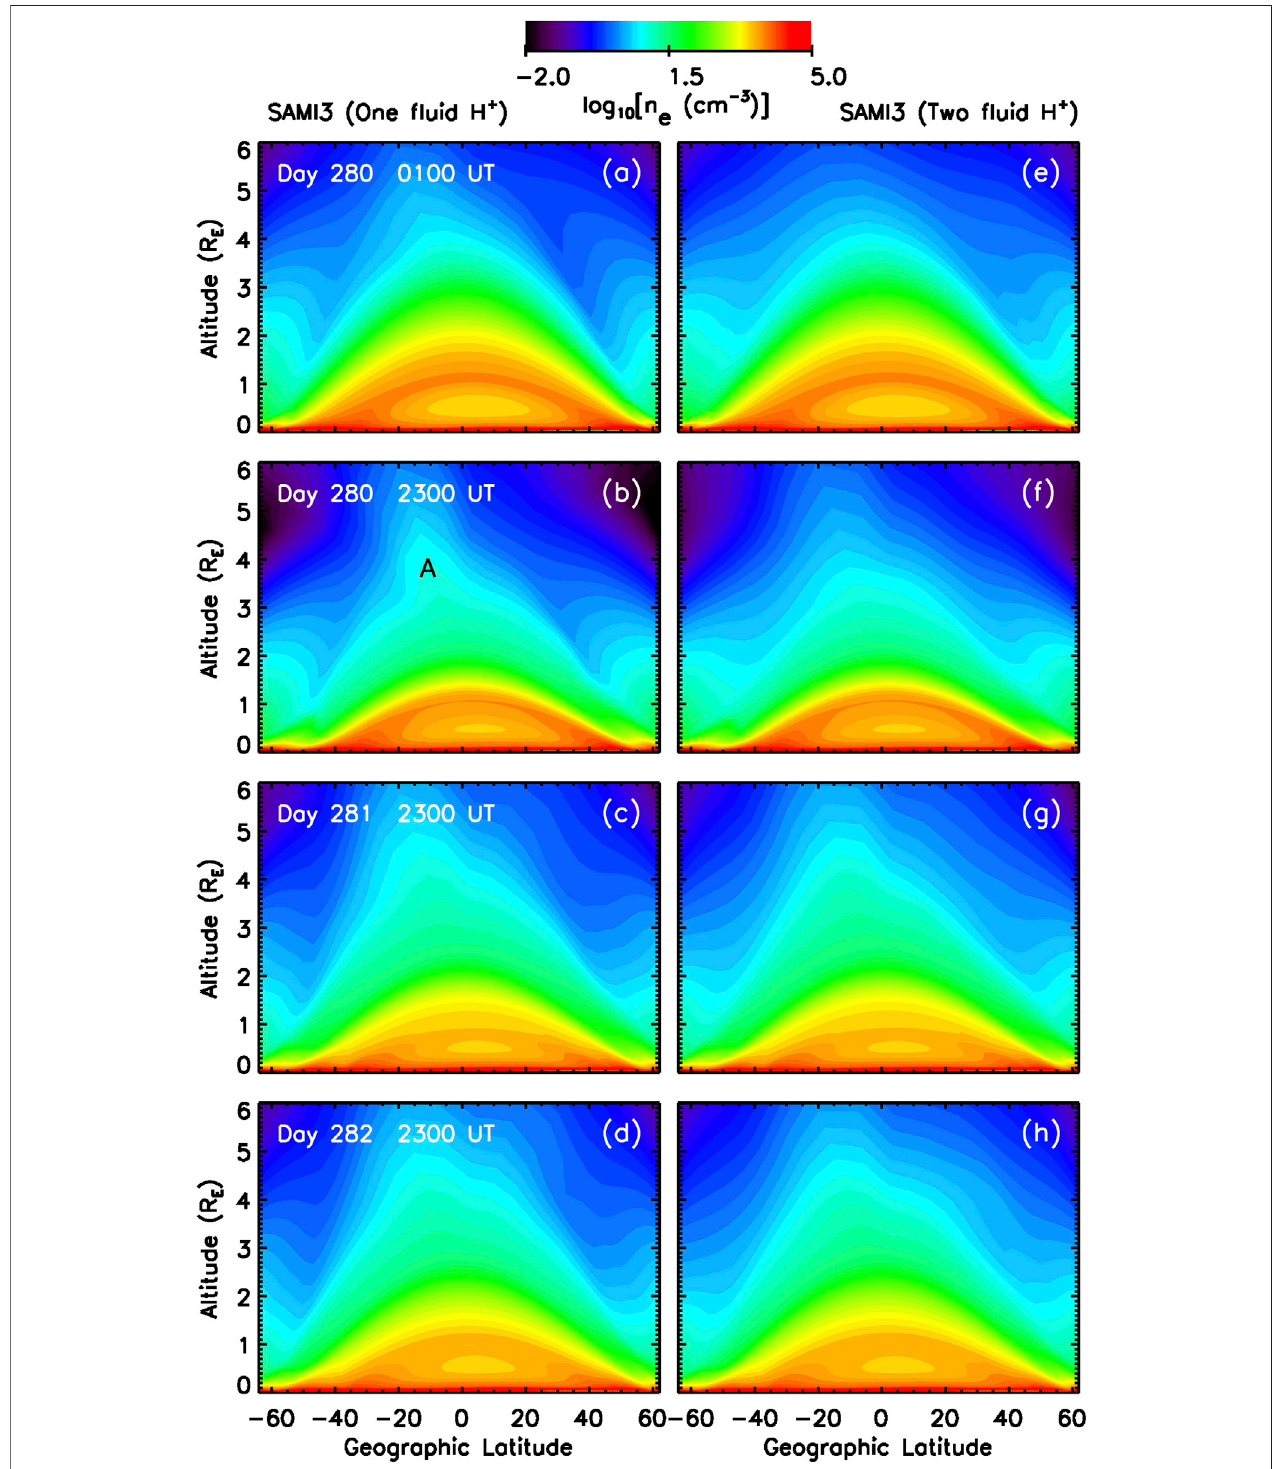
FIGURE 2 | Color contours of the log of the electron density are shown at times (A,E) 0100 UT Day 280 (before the storm), (B,F) 2300 UT Day 280 (during the storm), (C,G) 2300 UT Day 281 and (D,H) 2300 UT Day 282. Plots (A – D) are from SAMI3; plots (E – H) are from two-stream SAMI3. The density peak ( ‘ A ’ ) in panel (B) is caused by colliding H + streams from the two hemispheres. While a weaker version of feature A seems to be present in the two-stream SAMI3 result, panel (F) , analysis shows that panel (F) also includes a second, much weaker peak. Two days later, panels (D) and (H) , SAMI3 and two-stream SAMI3 come into closer agreement.